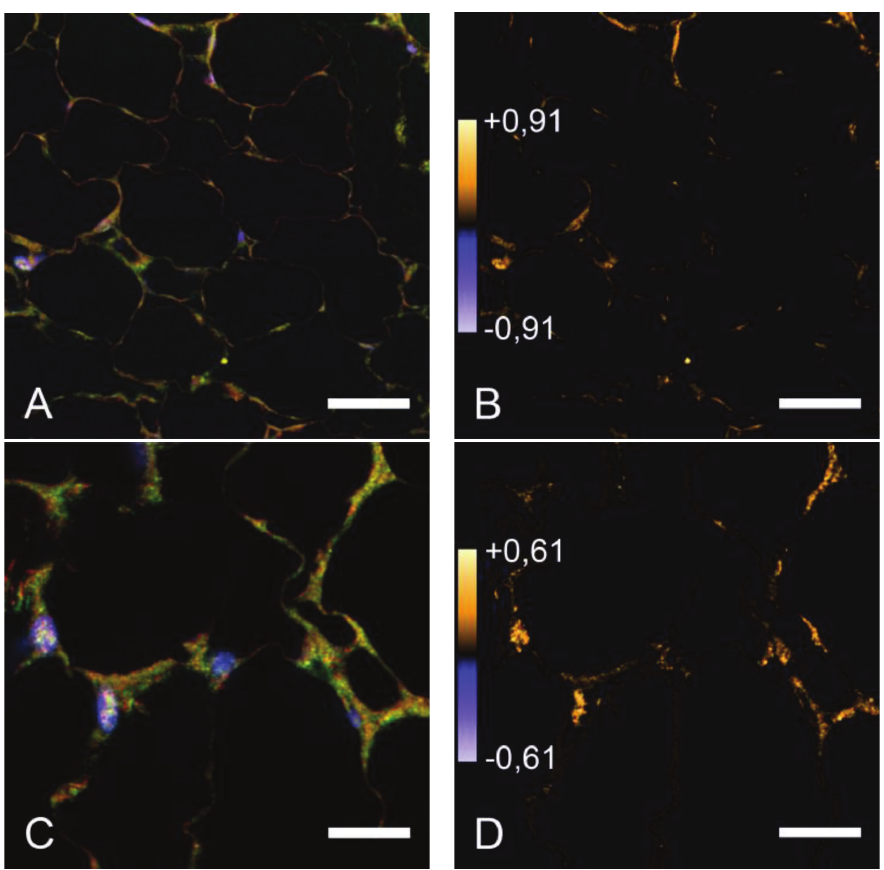
Figure3:ImmunostainingofPTPIP51,insulinreceptor,andPKAinadipocytesofstandarddietanimals.(A)ImmunostainingofPTPIP51and the insulin receptor. (B) Intensity correlation of PTPIP51 and the insulin receptor, high correlation is displayed in yellow. (C) Immunostaining of PTPIP51 and PKA. (D) Intensity correlation of PTPIP51 and the insulin receptor, high correlation is displayed in yellow; Bar (A): 60 𝜇 m; Bar (C): 15 𝜇